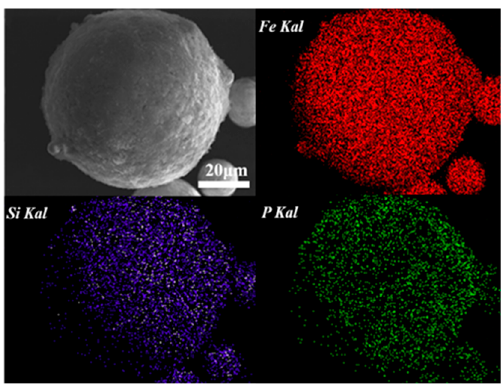
Figure 5. SEM micrograph and EDS elemental distribution maps of the coated Fe-6.5 wt%Si powders.